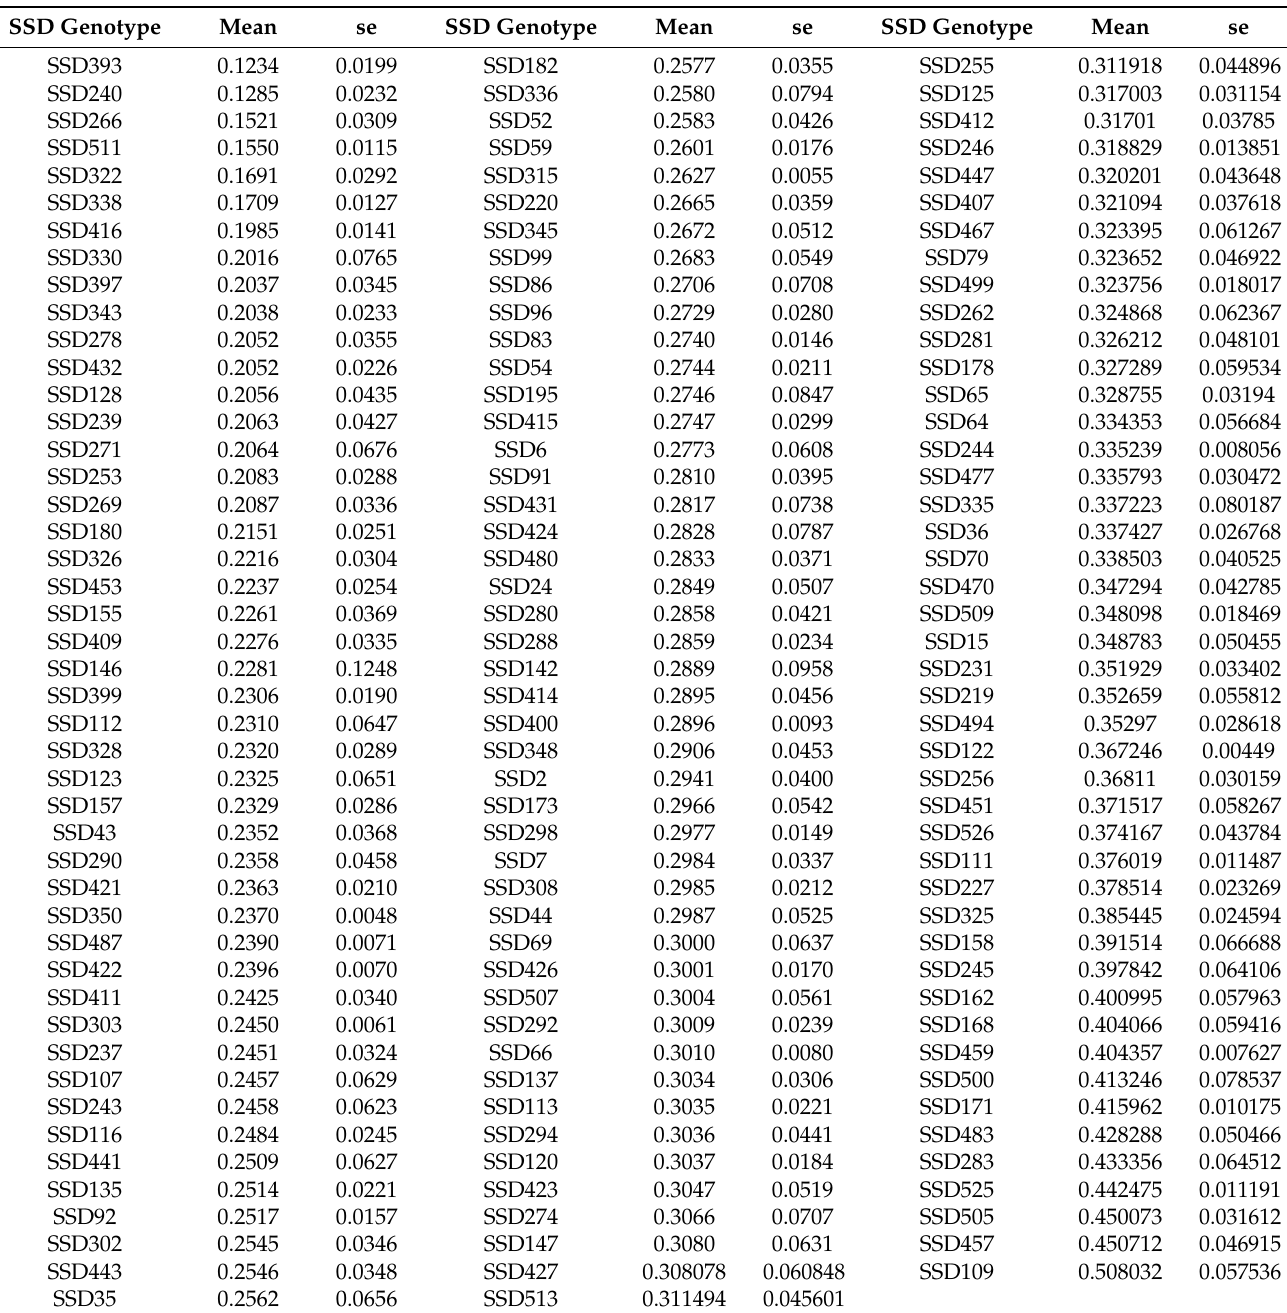
Table 2. Mean water content recorded for each genotype (SSD Genotype) expressed as the weighted mean of wet pixels. Genotypes are ordered based on a growing number of wet pixels. se, standard